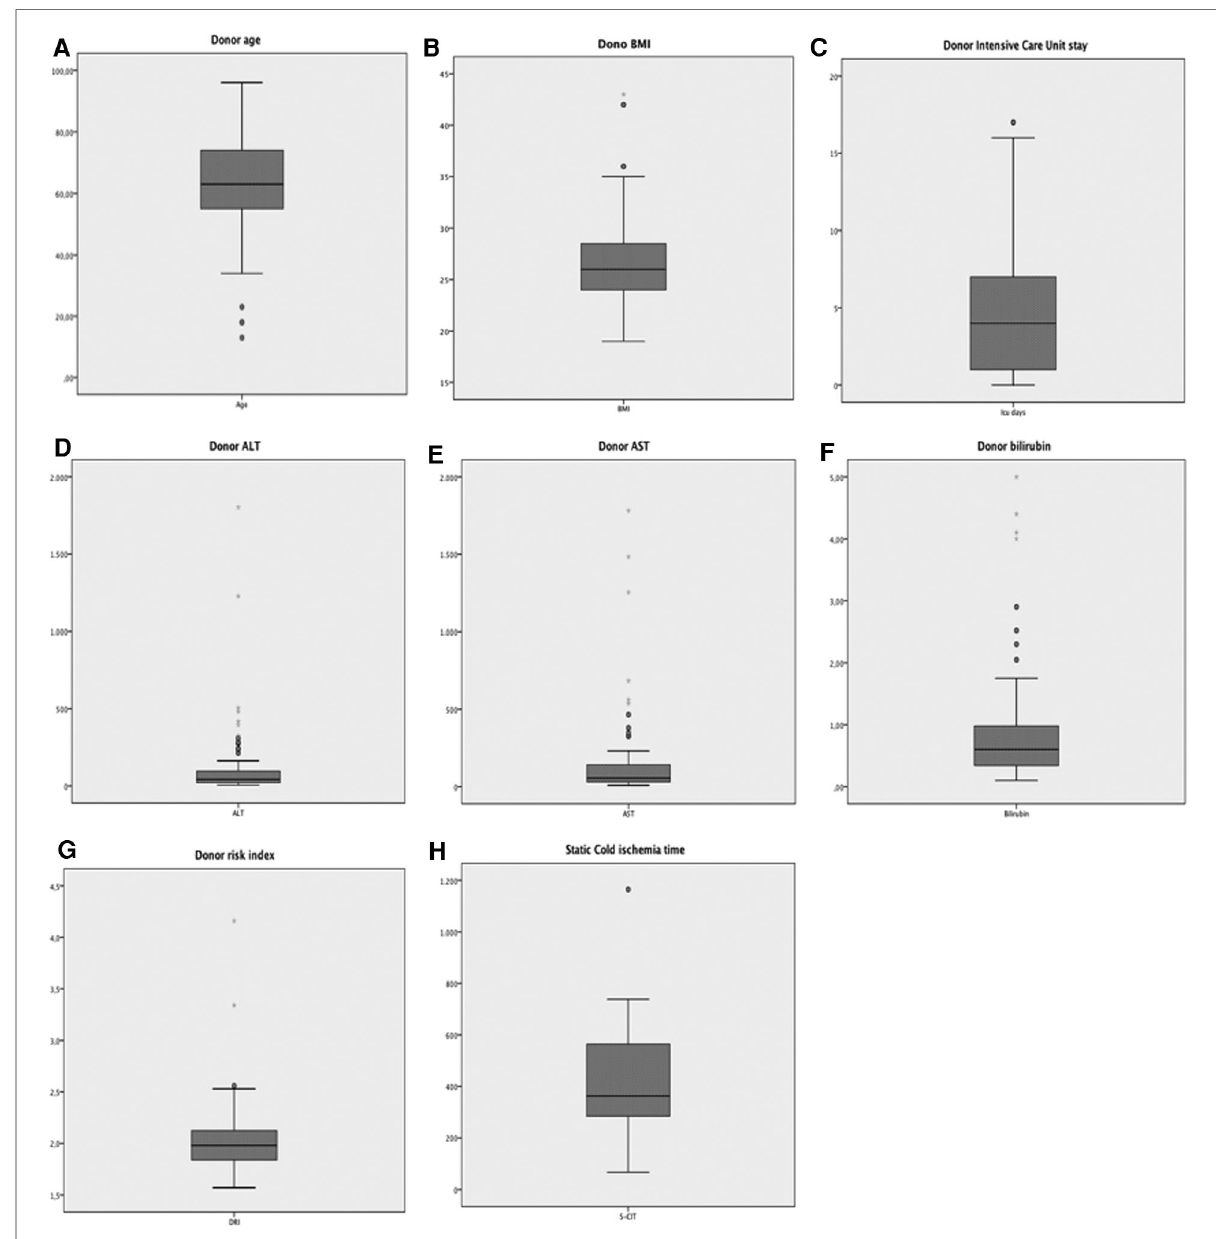
FIGURE 2 Graphic display of the distribution of the main donor parameters of all 158 donors included in the study. ( A ) Age; ( B ) BMI; ( C ) Intensive Care Unit stay; ( D ) ALT; ( E ) AST; ( F ) bilirubin; ( G ) donor risk index; ( H ) S-CIT